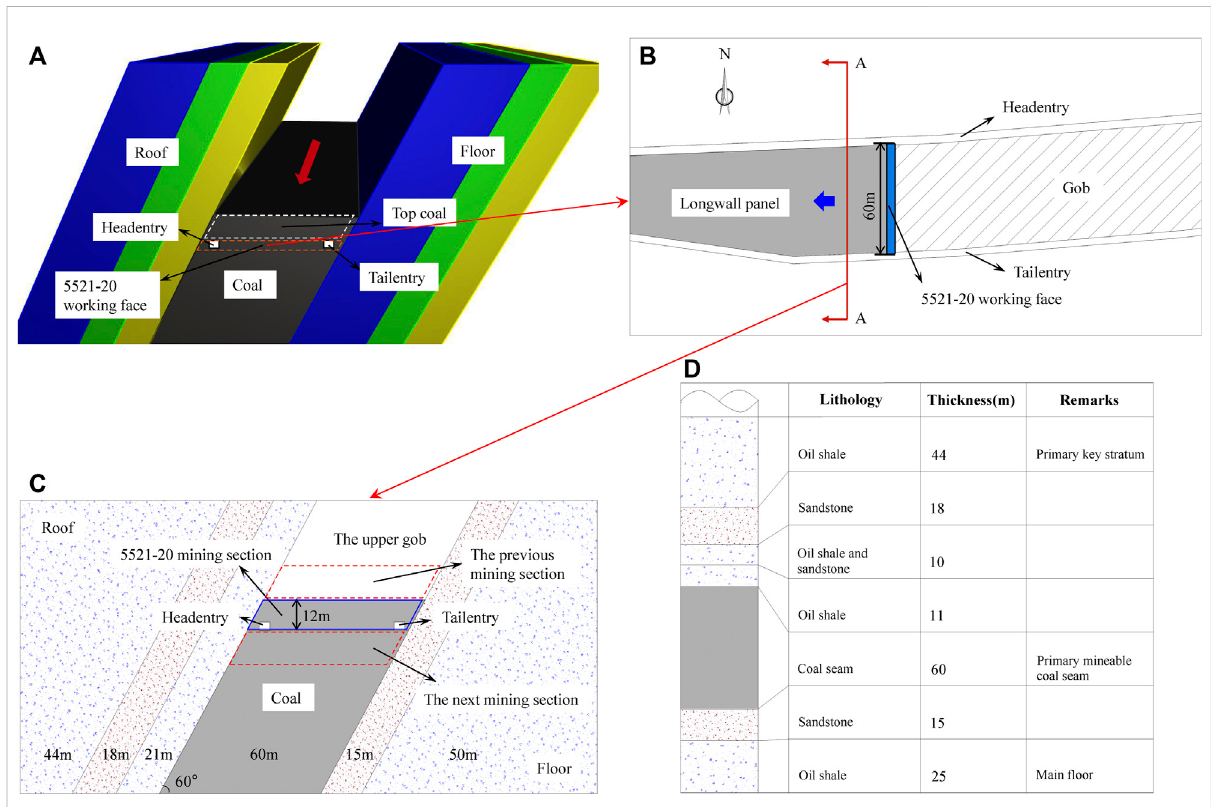
FIGURE 1 Thecoal mine: (A) thehorizontalsectionfull-mechanizedtop-coalcaving mininginSIETCS, (B) mininglayout, (C) cross-sectionofminingarea perpendicular to mining advance, and (D) geological pro fi